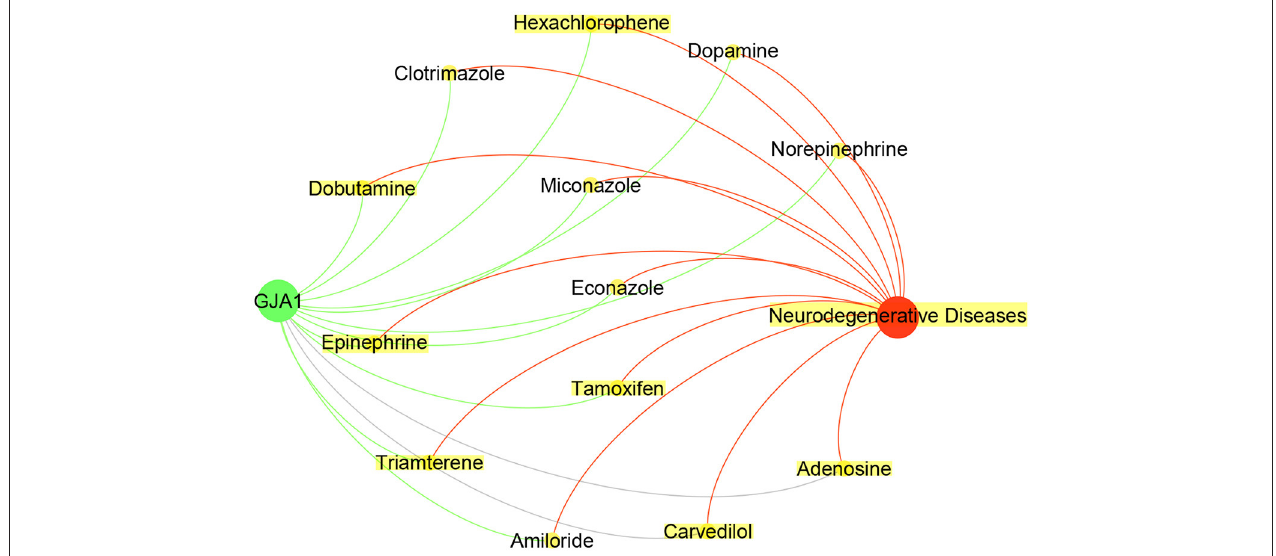
FIGURE 7 | Drug-GJA1-disease interaction network. The network contained candidate target GJA1 (green), Neurodegenerative Diseases (red) and 13 drugs (yellow).Gray indicate known interaction. Green and red lines and newly predicted interactions using deepDTnet and SAveRUNNER, respectively.